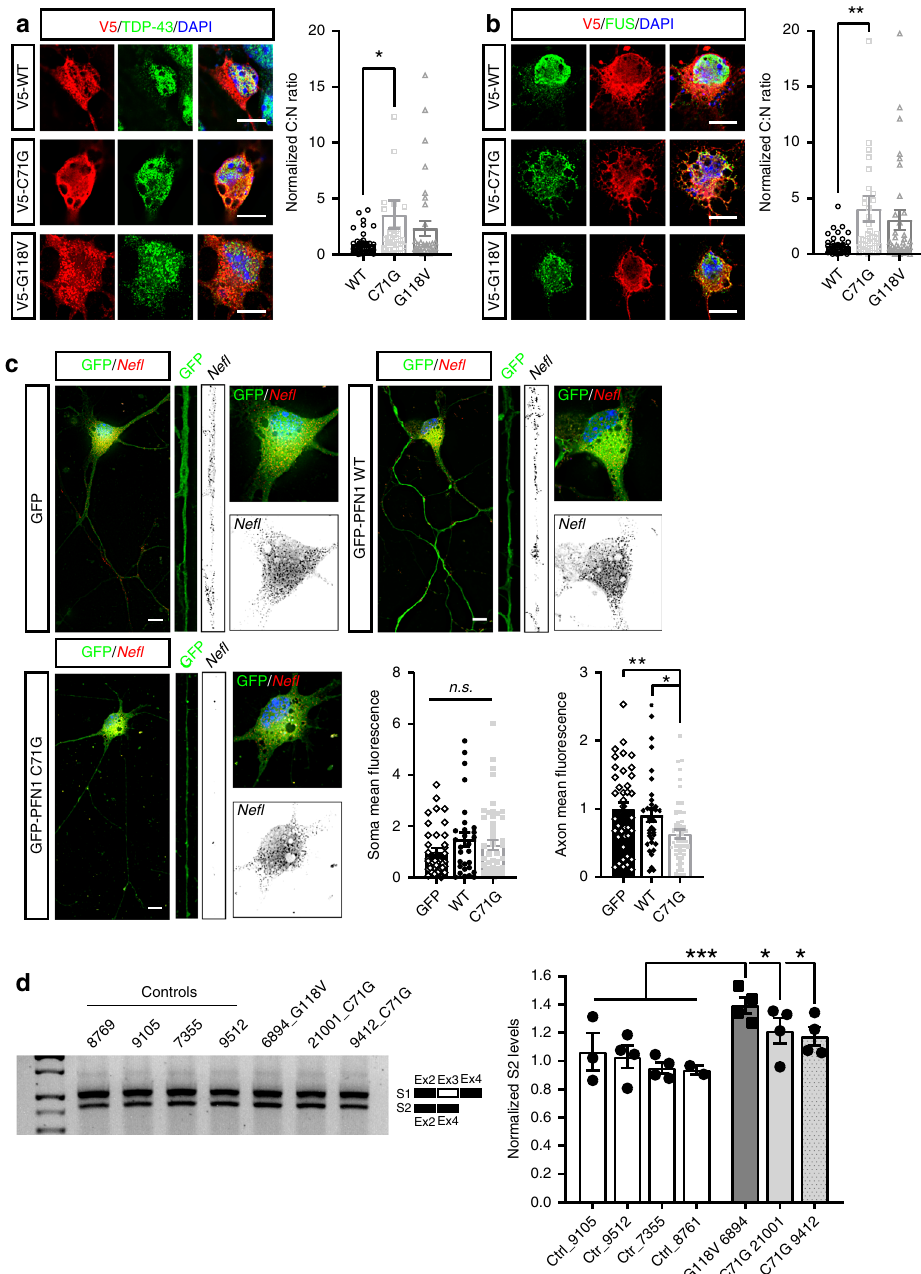
Fig. 5 Mutant PFN1 perturbs RBPs cellular distribution and function. a , b Mutant PFN1 (red) causes redistribution of nuclear RBPs TDP-43 ( a , green) and FUS ( b , green) to the cytoplasm, as quanti fi ed by their cytoplasm to nucleus (C:N) ratios. c RNA-FISH analysis reveals that the Ne fl mRNA ( black ) levels in the axon, but not in the cell soma, are signi fi cantly reduced due to the expression of GFP-PFN1 C71G (green) compared to GFP or GFP-PFN1 WT -expressing MNs. d Representative DNA gel and quanti fi cation of the levels of the POLDIP3 S2 variant over total POLDIP3 levels (S1 + S2) in controls versus mutant PFN1 lymphoblast lines. DAPI (blue) was used to detect the nucleus and assess cell health. Scale bars: 10 µ m. Bars are mean ± SEM; * p < 0.05, ** p < 0.01, *** p < 0.001. N = 34 – 47 cells from 3 – 4 independent experiments ( a , b ), 29 – 53 cells from 4 independent experiments ( c ), 4 independent experiments ( d ). See also Supplementary Figs. 5 – 10, and Supplementary Table 1 for details on